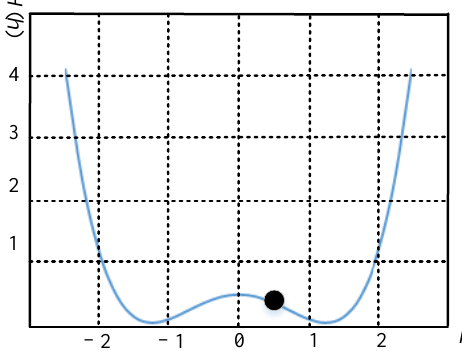
Figure 1. Situation of the system with a = b =